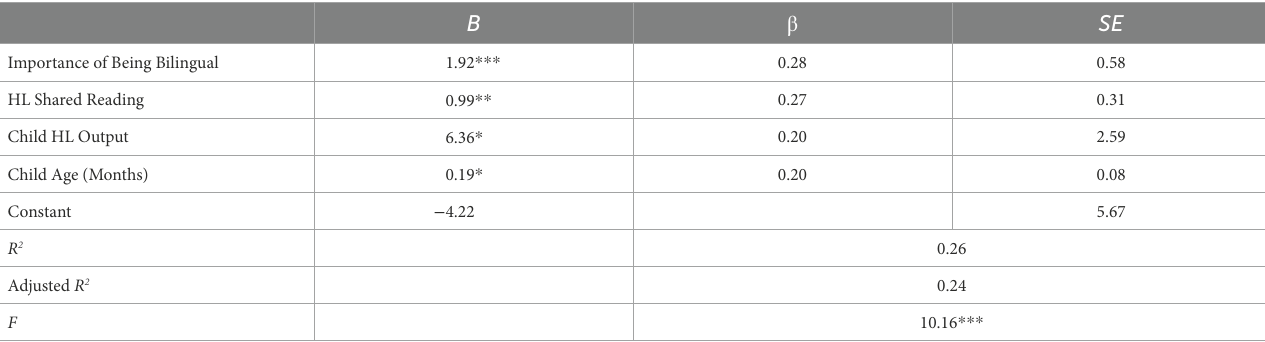
TABLE 4 Stepwise regression analysis predicting home language oral proficiency.